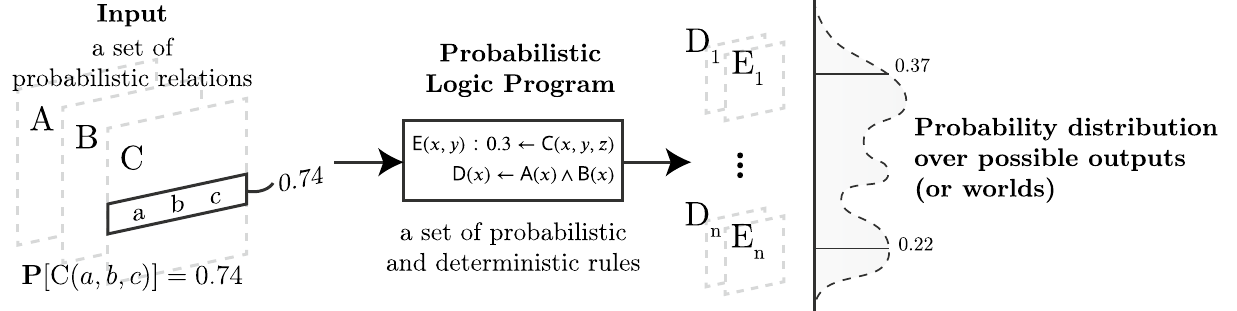
Figure 7. A probabilistic logic program defines a probability distribution over its possible outcomes. Note that the probabilities and the distribution are arbitrary and are used for illustration only.